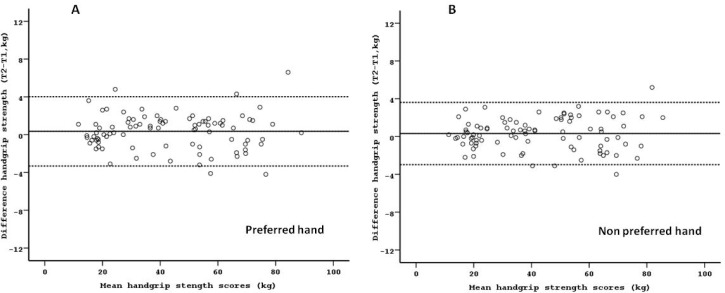
Bland-Altman plots of the handgrip strength test for preferred and non-preferred hand in the whole group. The central line characterizes the mean difference between test and retest values; the upper and lower lines characterize the upper and lower 95 % limits of agreement (LOA = inter-trials mean difference ± 1.96 SD of the inter-trials difference), respectively